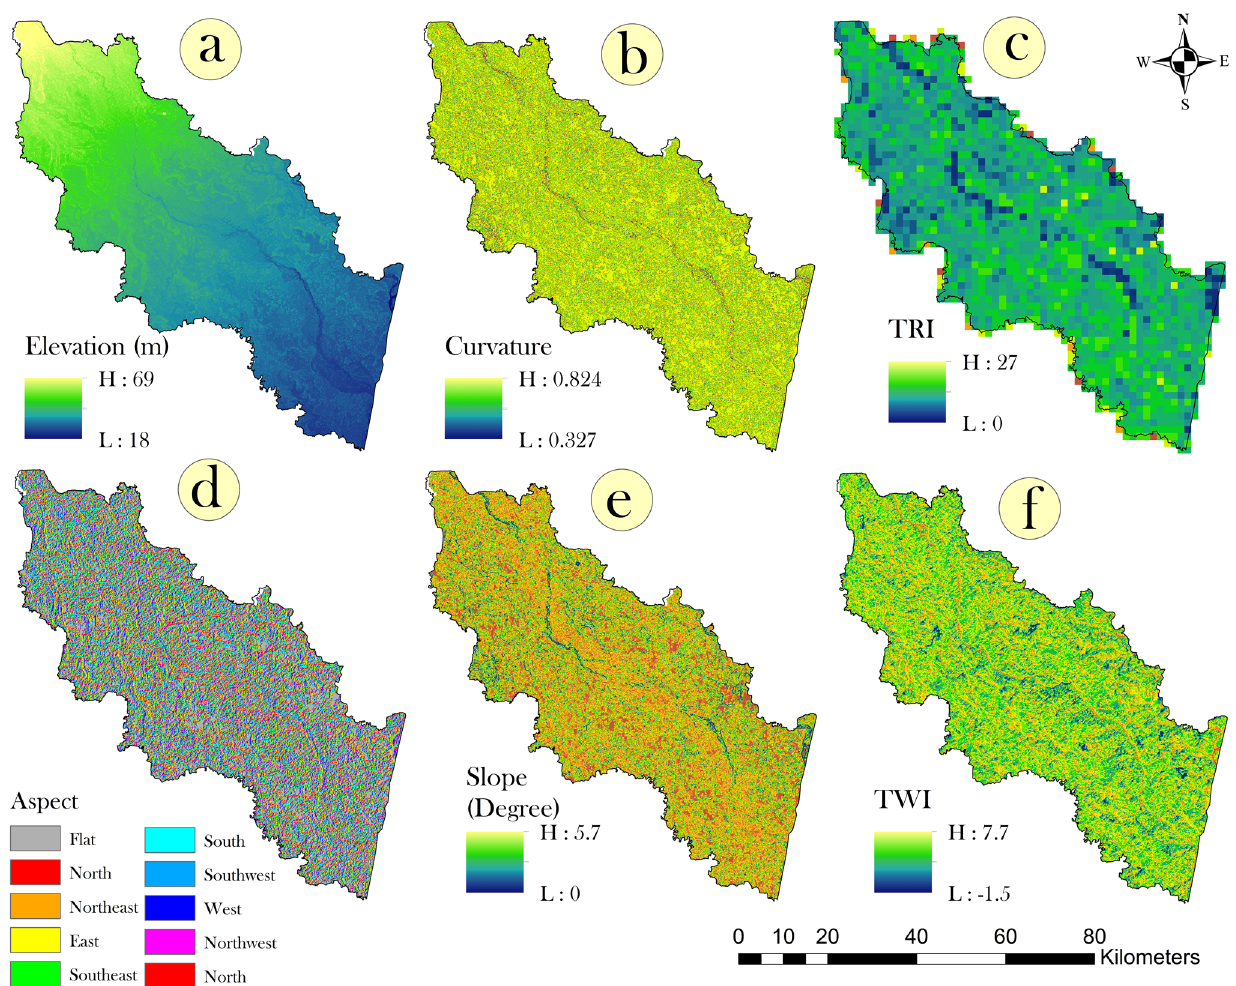
Fig. 2 Thematic parameters for GWP modeling such as a elevation, b curvature, c TRI and d aspect, e slope, and f